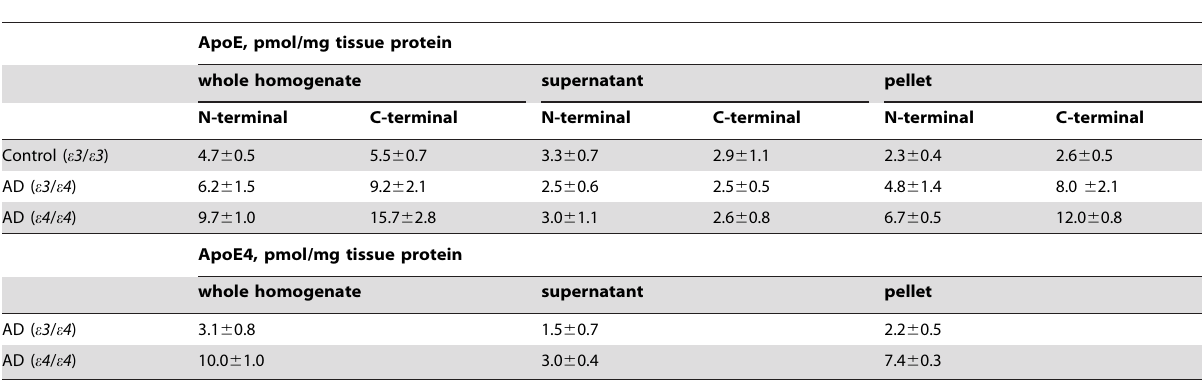
Table 1. Comparison of total apoE and apoE4